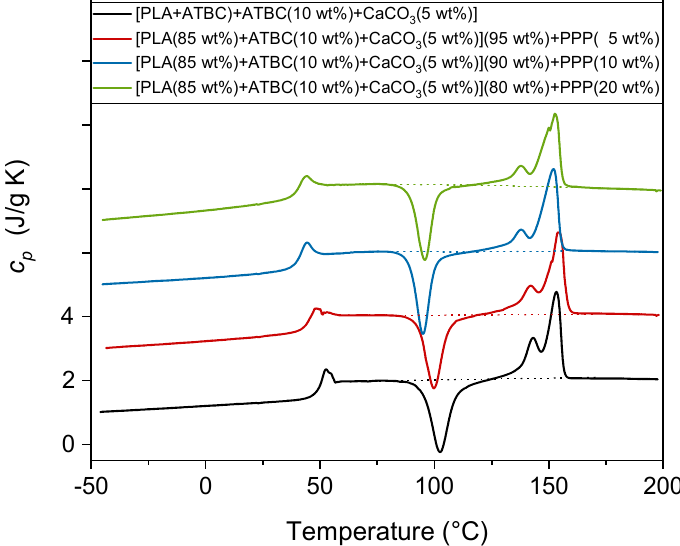
Figure 6. Specific heat capacity ( c p ) of the PLA-based matrix and biocomposites indicated in the legend. The curves were obtained upon heating at 10 K/min after previously fast cooling to -50 °C. The dotted lines are the baselines used for the calculation of the Δ h c and Δ h m values. The ordinate values refer only to the bottom curve. All the other curves are shifted vertically for the sake of clarity. Table 3. Glass transition temperatures ( T g ), enthalpy of cold crystallization (Δ h c ), enthalpy of fusion (Δ h m ), and crystalline weight fraction growing during cold crystallization ( w Cc ) and disappearing during fusion ( w Cm ) for the PLA-based matrix and biocomposites (estimated errors: ± 0.5 °C for T g ; ± 1 J/g for Δ h c and Δ h m , and ± 0.02 for w Cc and w Cm ). 0.34 The w Cc and w Cm values listed in Table 3, as derived from the measured Δ h c and Δ h m values, respectively, reveal that the PLA-based biocomposites containing PPP, processed for 1 min at 90 °C, are completely amorphous. Despite the nucleating action of PPP, which leads to a progressively and slightly higher crystallinity to develop upon heating, the residence time of the materials in the mold is too short to allow the crystallization of PLA. The mechanical properties of the [PLA (85 wt%) + ATBC (10 wt%) + CaCO3 (5 wt%)] matrix and the biocomposites with potato pulp powder are summarized in Figure 7. As a general rule, the modulus of a composite depends on the modulus of both the matrix and the reinforcement and filler, and the modulus of the natural fibers is generally higher than the modulus of the polymeric matrices [12]. Figure 7 reveals that the elastic modulus decreases by increasing the PPP percentage, which could mean that PPP acts for PLA matrix as filler and not as reinforcement, or it could be ascribed to PLA degradation during the processing step induced by fiber moisture [53]; although, both PLA and the PPP powder were previously dried for a long time, and the water content of the potato pulp powder was about 3 wt% (Figure 1). The number-average molar mass ( M n ) and the mass-average molar mass ( M w ) of PLA of both the matrix and the biocomposite with 20 wt% of potato pulp powder processed under identical conditions were measured by size exclusion chromatography (SEC). For the PLA-based matrix, M n = 92,000 g/mol and